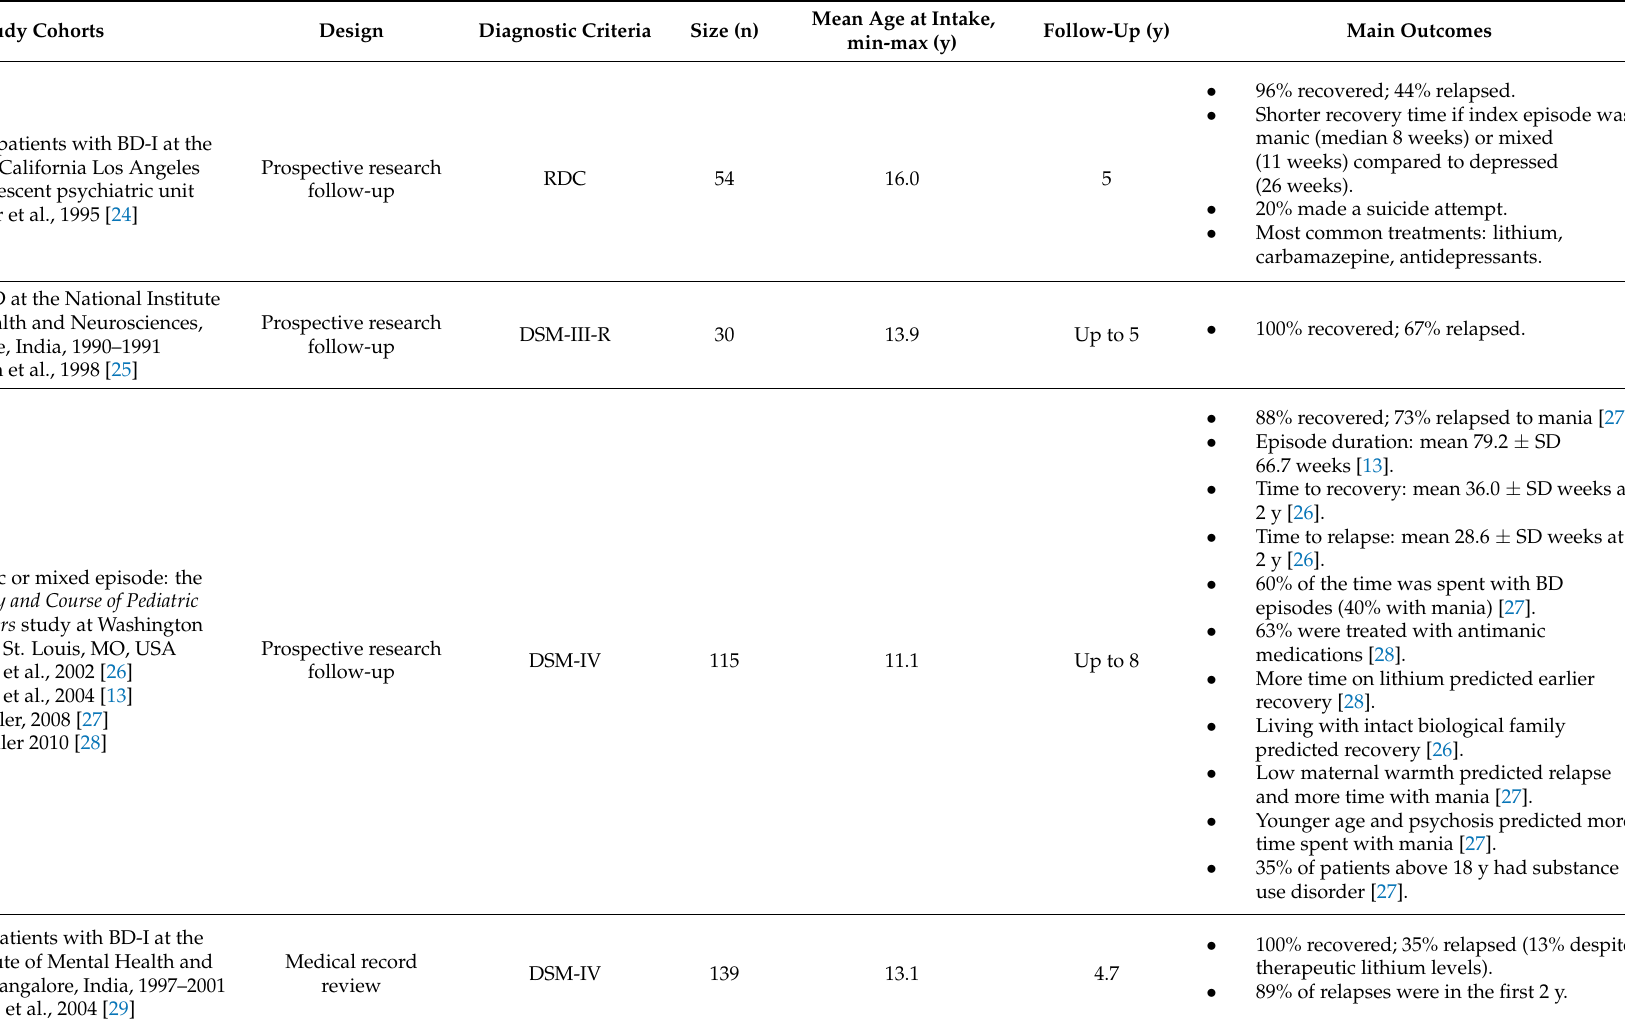
Table 1. Patient cohorts used to examine the course of bipolar disorder in children and